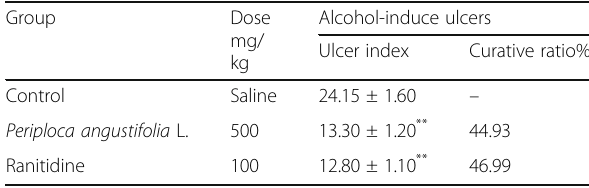
Table 3 The effect of P. angustifolia L. extract on alcohol-induce ulcer in rats (n = 5)